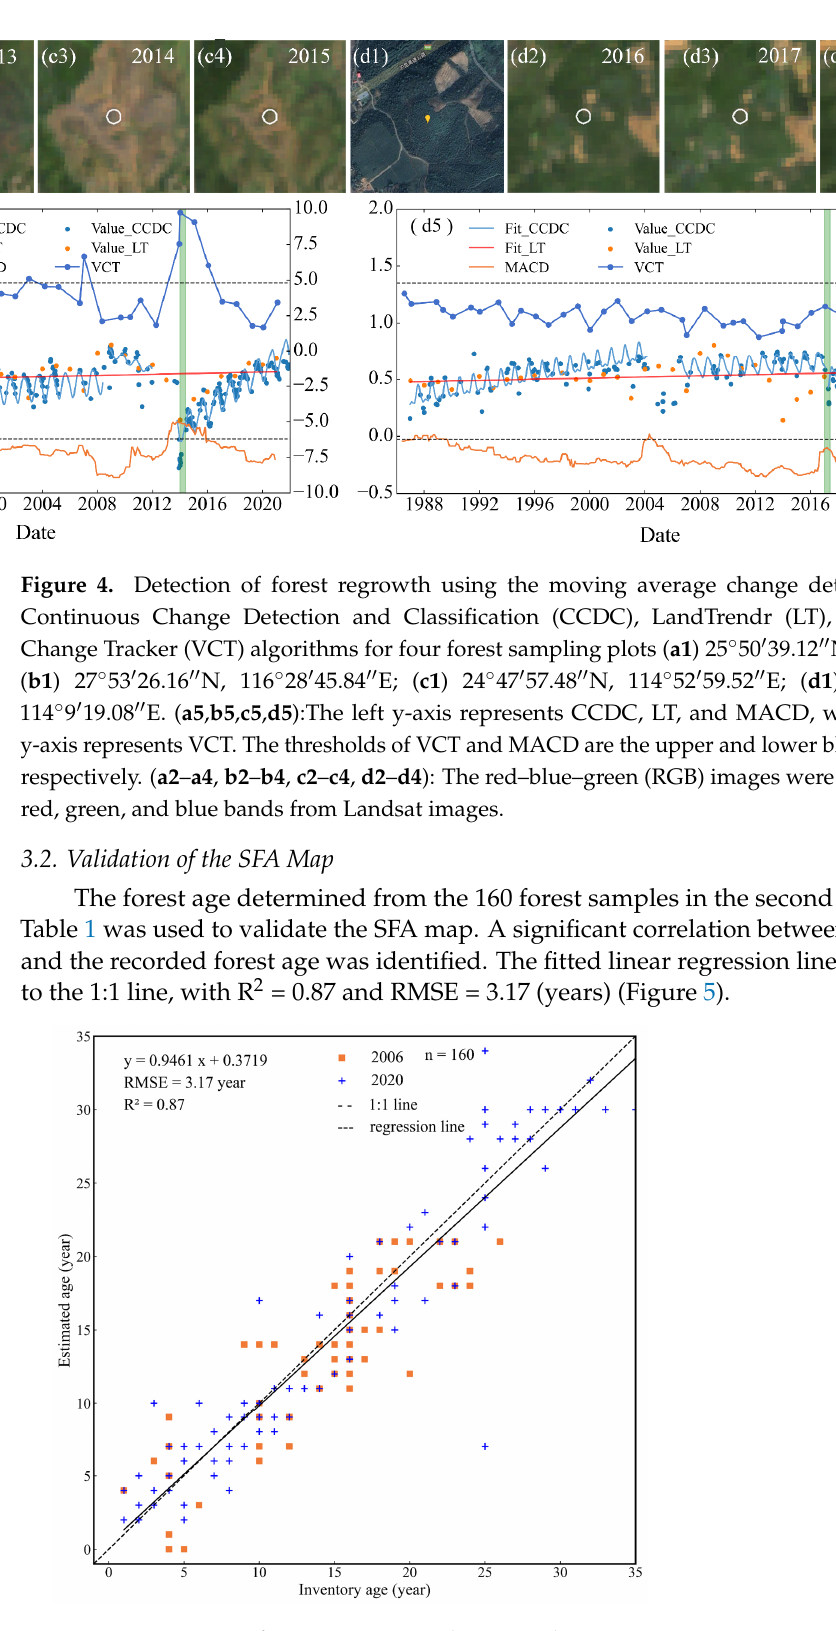
Figure 5. Comparison of inventory SFA and estimated SFA.